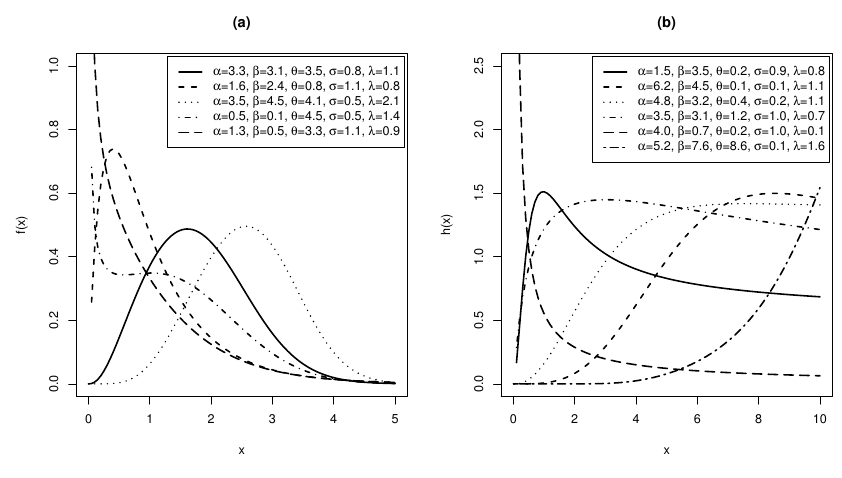
Figure 1 – Plots of the density and hazard functions of EOLxW for some possible parameter